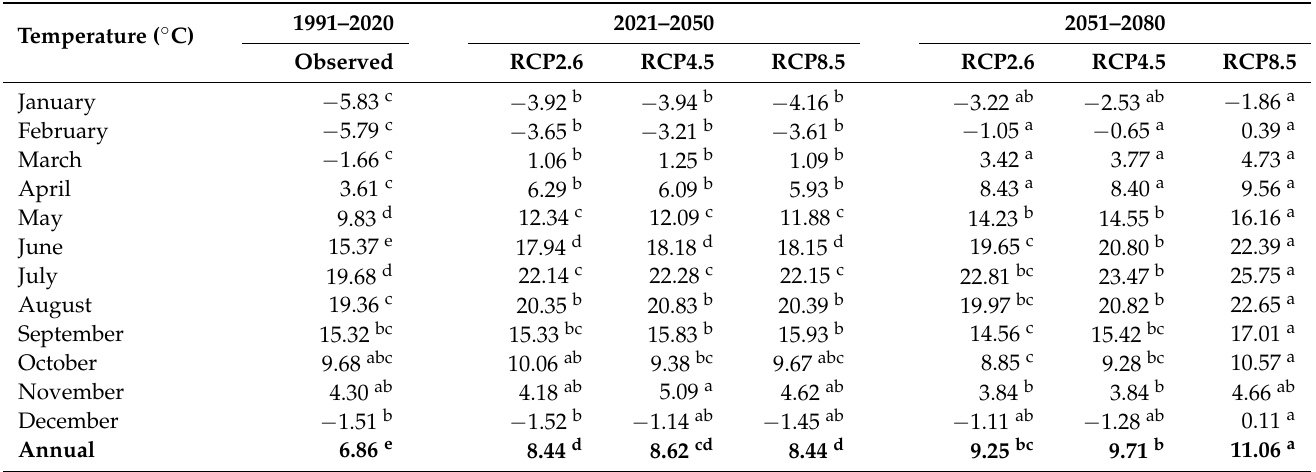
Table 4. Average temperatures ( ◦ C) that prevailed in the eastern zone (Alliston) during the 2000s, and expected under different projections during the 2030s and